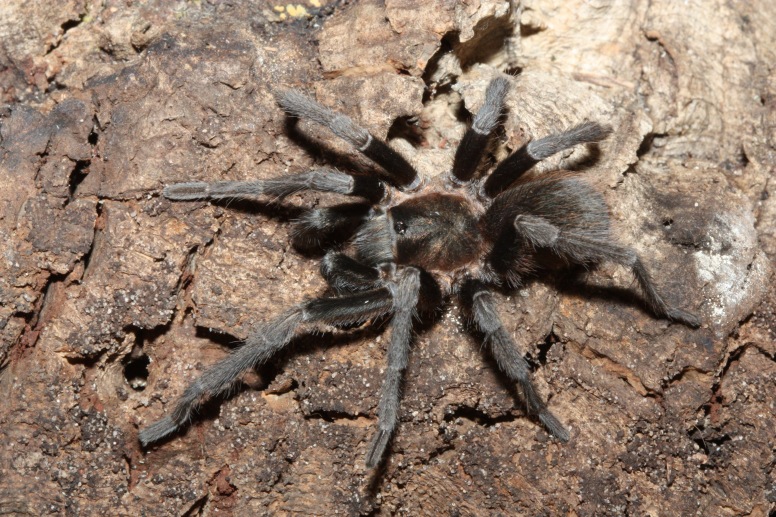
Sandinista
lanceolatum (Simon, 1891) male from Jinotepe, Carazo department, Nicaragua. Photo: Stuart J. Longhorn.